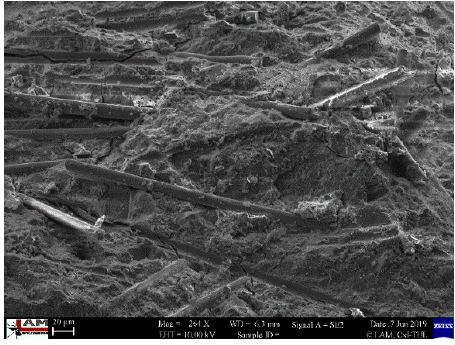
Figure 6. SEM microstructure of geopolymer mortar at the age of 28 days after casting.